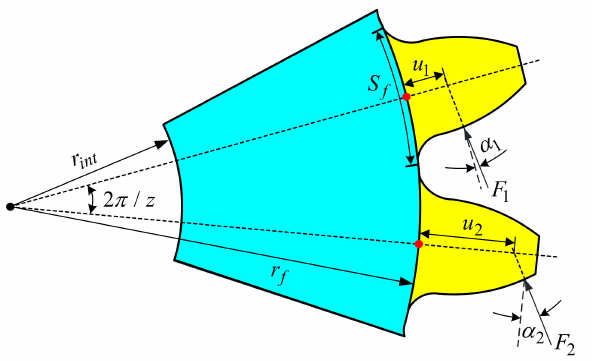
Figure 2. Schematic diagram of structural coupling effect in the double teeth-meshing